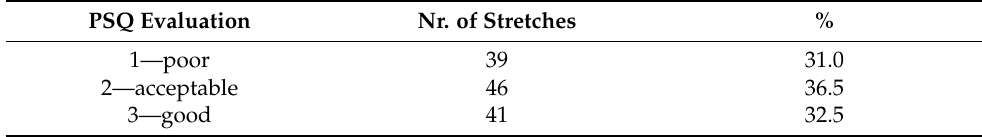
Table 2. Pedestrian surface quality (PSQ).